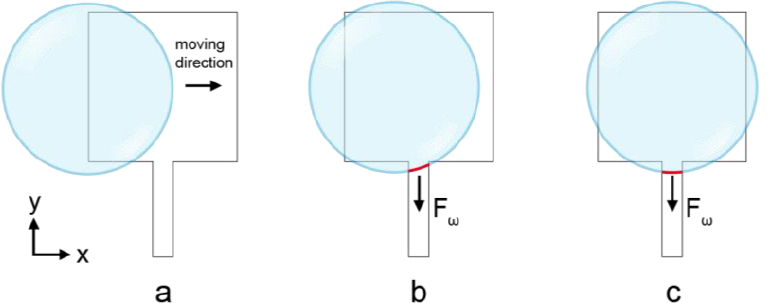
Figure 2. The simulation model for investigating the effect of lead wire on the deformation of a droplet. For the move-in model, a droplet driven by the capillary force toward the x -axis does not make contact with the lead wire at the initial stage ( a ); as it moves close to the center of the electrode, it makes contact with the lead wire and an additional force toward the direction of the lead wire is produced ( b ). For the activation model, the droplet is positioned at the center of the electrode and makes contact with the lead wire ( c ).